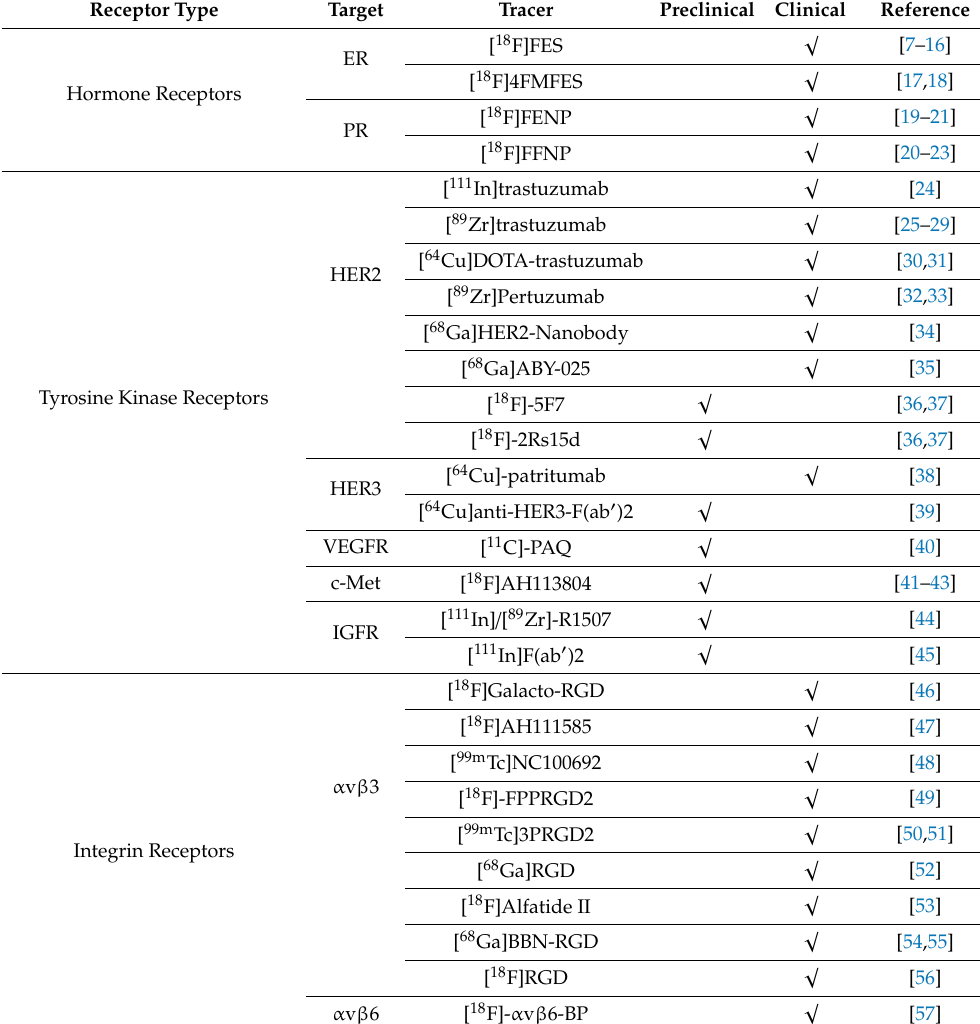
Table 1. Summary of tracers targeting receptors for breast cancer